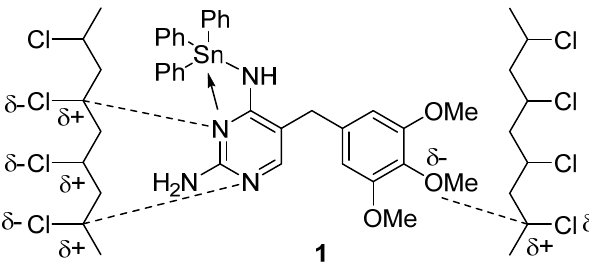
Figure 10. Interaction between complex 1 and PVC.